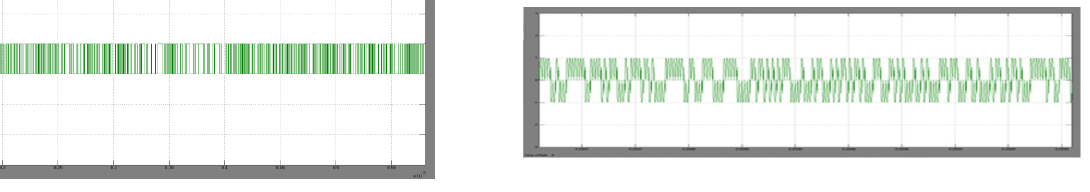
Fig. 17. In-phase Data after Half Sine Pulse- Shaping.